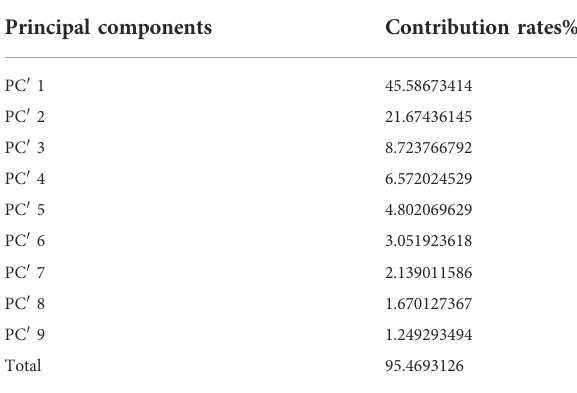
four sets were given by algorithm contained in MATLAB automatically).